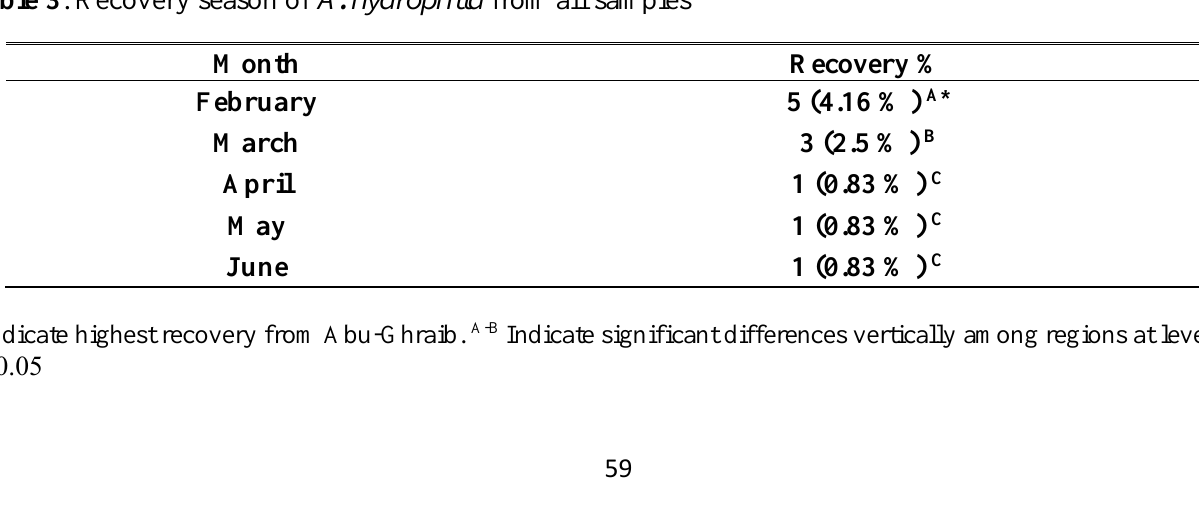
* Indicate highest recovery from Abu-Ghraib. A-B Indicate significant differences vertically among regions at level P≤0.05. Table 3 . Recovery season of A. hydrophila from all